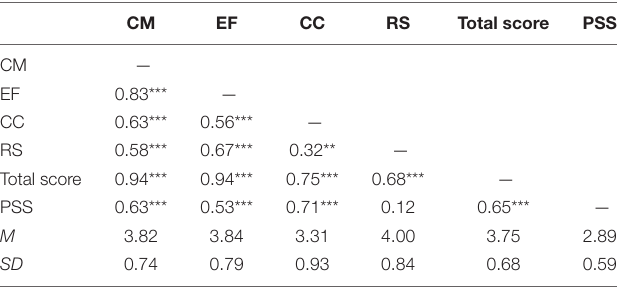
TABLE 6 | Correlation analysis between PSS and total scores and factors of parenting stress of two-child mothers ( n = 77).